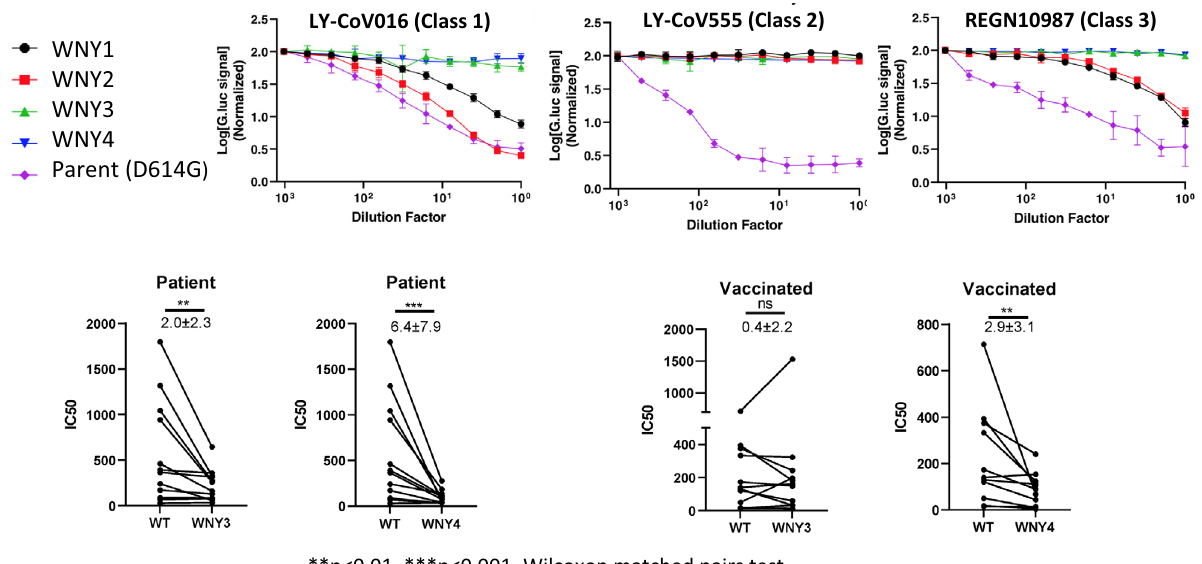
Fig. 3 Antibody resistance to monoclonal neutralizing antibodies and patient plasma. Lentiviral reporter pseudoviruses containing Gaussia luciferase were generated with parent (D614G), WNY1, WNY2, WNY3, or WNY4 Spike proteins. These pseudoviruses were treated with 2-fold dilutions of indicated monoclonal neutralizing antibody or patient serum and used to infect 293FT + TMPRSS2 + human ACE2. Gaussia luciferase levels were quantitated approximately 2 – 3 days of post-transduction. Representative examples of three experiments with monoclonal antibodies performed in triplicate are shown. Infection was normalized to the wells infected with pseudovirus alone. Patient plasma Neutralization IC50 titers were calculated using nonlinear regression (Inhibitor vs. normalized response — variable slope) in GraphPad Prism 9.0. The number indicates the mean fold of reduction in IC50 and SD. Wilcoxon matched-pairs signed rank tests, a two-tailed test, were performed for paired comparisons with signi fi cance levels as follows: WNY3 patient p = 0.0049, WNY4 patient p = 0.001, and WNY4 vaccinated = 0.0068. Source data are provided as a Source Data fi